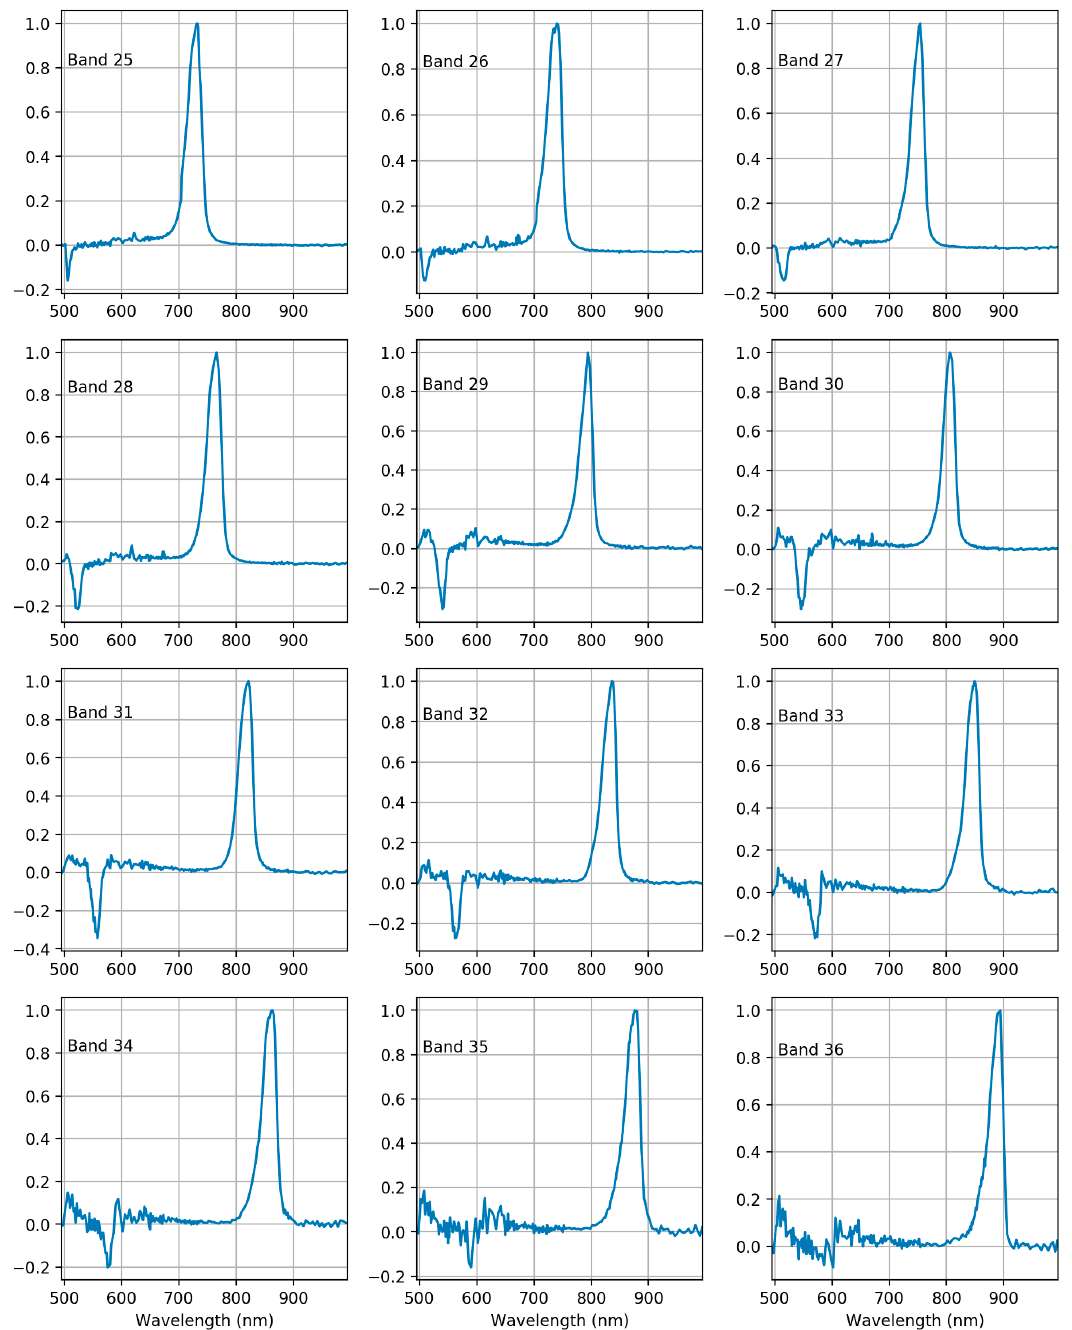
Figure A3. FPI spectral response curves for bands 25–36. Curves are scaled so that the maximum value is 1.